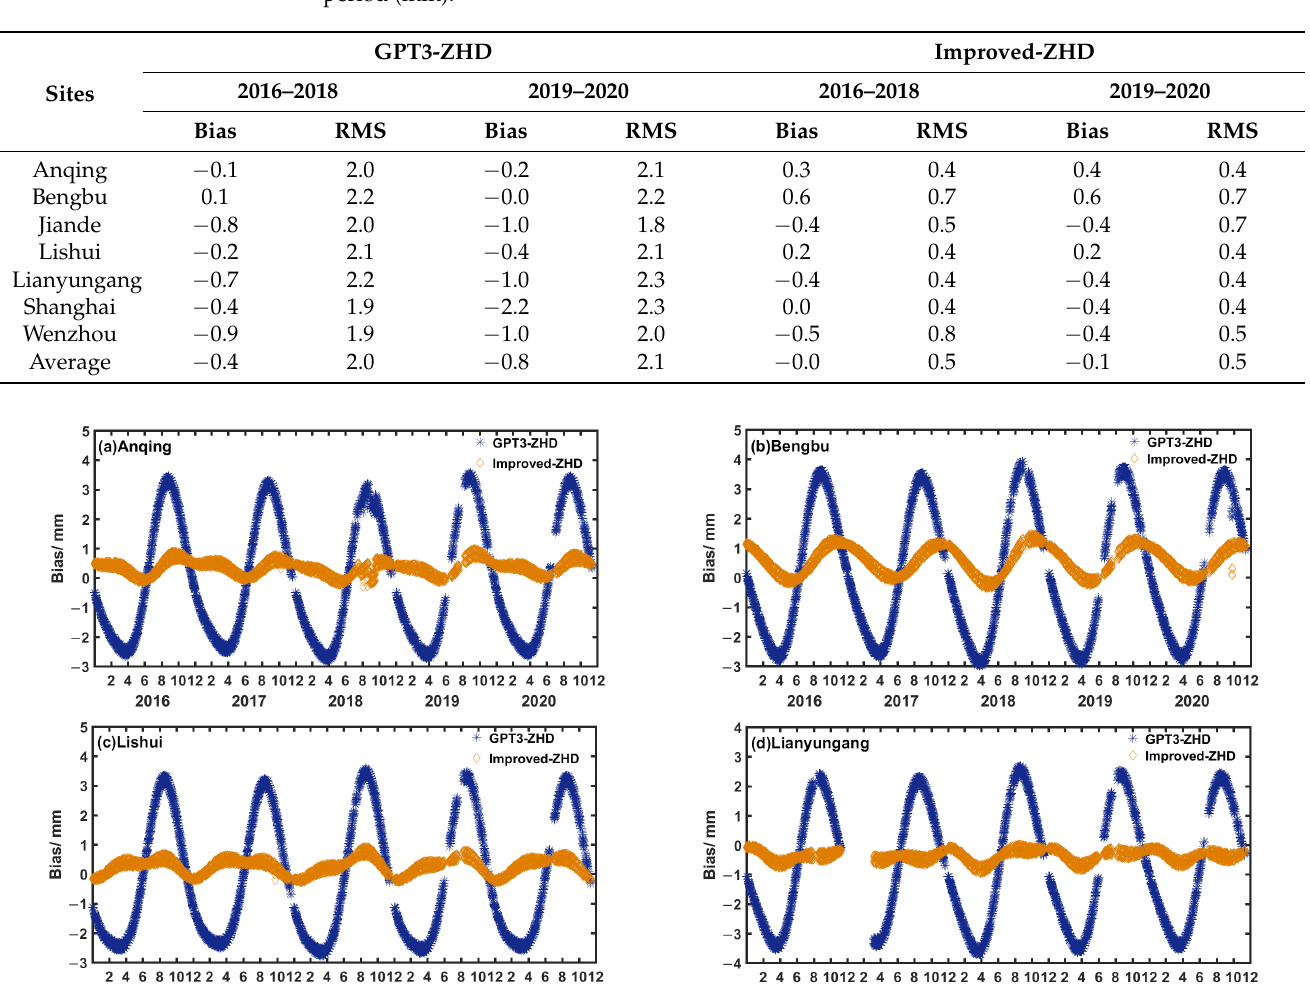
Figure 3. Bias and fitting curves of the GPT3-ZHD bias in the Yangtze River Delta region during Table 2. The precision of improved ZHD in the Yangtze River Delta region during the 2016–2020 period (mm).